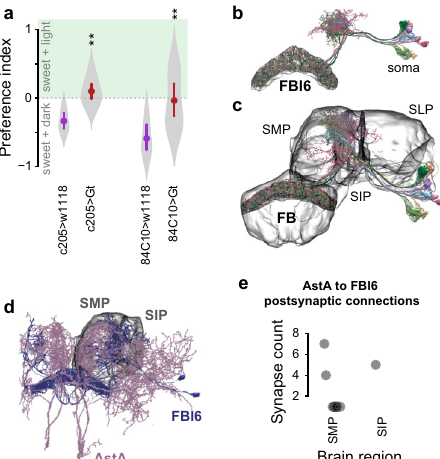
Fig. 5 FBl6 neural activity is context-dependent. a Food preference index of fl ies with spatially restricted persistent optogenetic inhibition. FBl6 neurons are optogenetically inhibited in one half of the arena that contains only sweet food on both sides. This inhibition abolishes aversion for bright green light by shifting food preference away from dark half of the arena. Points on graphs depict mean ± 95% CI, with violins depicting full data distribution. b EM reconstruction of FBl6 neurons shows neural projections restricted to layer 6 of the fan-shaped body. EM reconstruction of traced FBl6 neurons from the Janelia hemibrain dataset was performed using neuPrint and NeuronBridge for neurons targeted by 84C10-GAL4 and embedded in the surface representation mesh of standardized FBl6 brain region. c EM reconstruction of FBl6 neurons targeted by 84C10-GAL4 was performed as previously and embedded in the surface representation mesh of standardized whole fan-shaped body (FB). FBl6 neural projections to superior medial protocerebrum (SMP), superior intermediate protocerebrum (SIP), and superior lateral protocerebrum (SLP) higher brain regions are shown embedded in the surface representation of these standardized higher brain regions. d AstA neurons make postsynaptic connections with FBl6 neurons in SMP and SIP brain regions. Surface representations of brain regions where AstA neurons make postsynaptic connections with FBl6 neurons are shown in gray. EM analysis of traced AstA neurons that make postsynaptic connections with FBl6 neurons was performed in neuPrint. e Quanti fi cation of number of postsynaptic connections from AstA to FBl6 neurons. Each gray dot represents the number of synaptic connections between one AstA and one FBl6 neuron, separated by brain region on the x-axis where these connections are